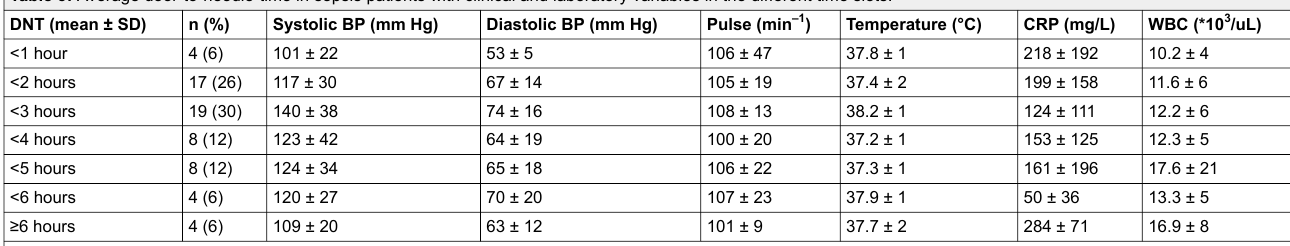
Table 3: Average door-to-needle-time in sepsis patients with clinical and laboratory variables in the different time slots. DNT (mean ±